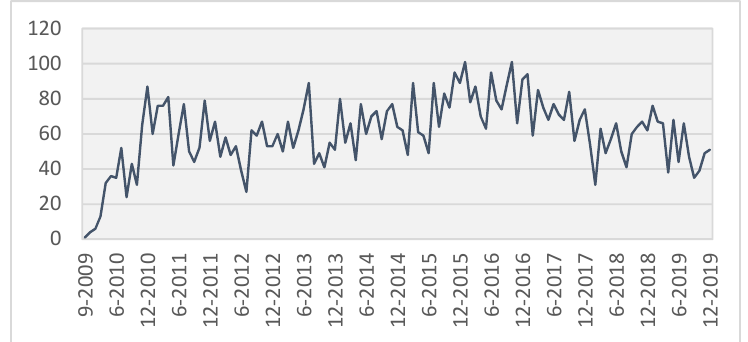
Figure 14. Road accident deaths data for December 2009–December 2019.